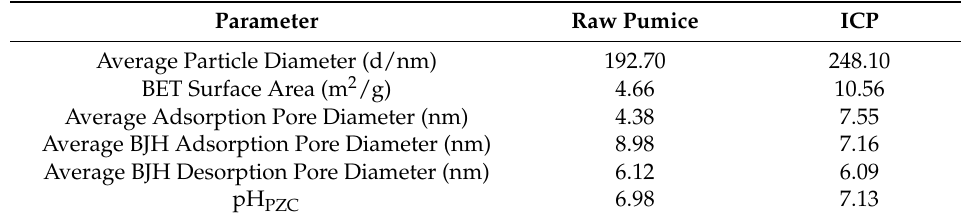
Table 1. DLS and BET analysis results of crude and iron coated pumice.